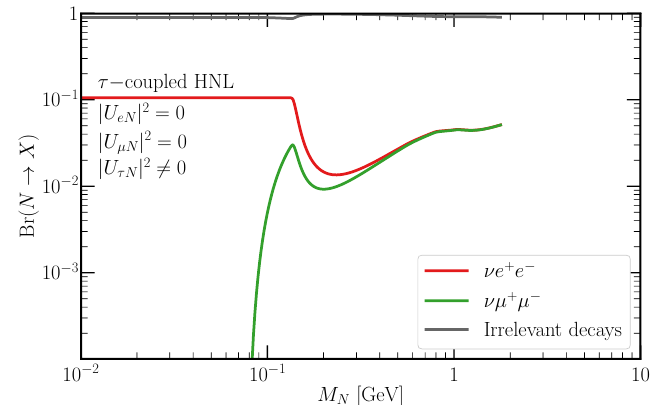
Figure 23 . The branching ratio of a tau-coupled HNL N into di(cid:11)erent (cid:12)nal states as a function of its mass M N . The grey curve is a collection of decays considered to be irrelevant, as described in the text. Because we do not consider any M N > m (cid:28) , we do not present any branching fractions in this